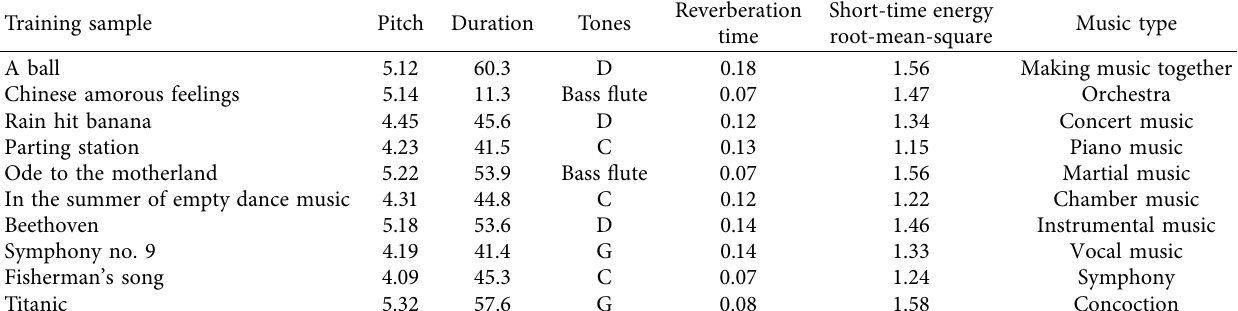
Table 3: Experimental results.